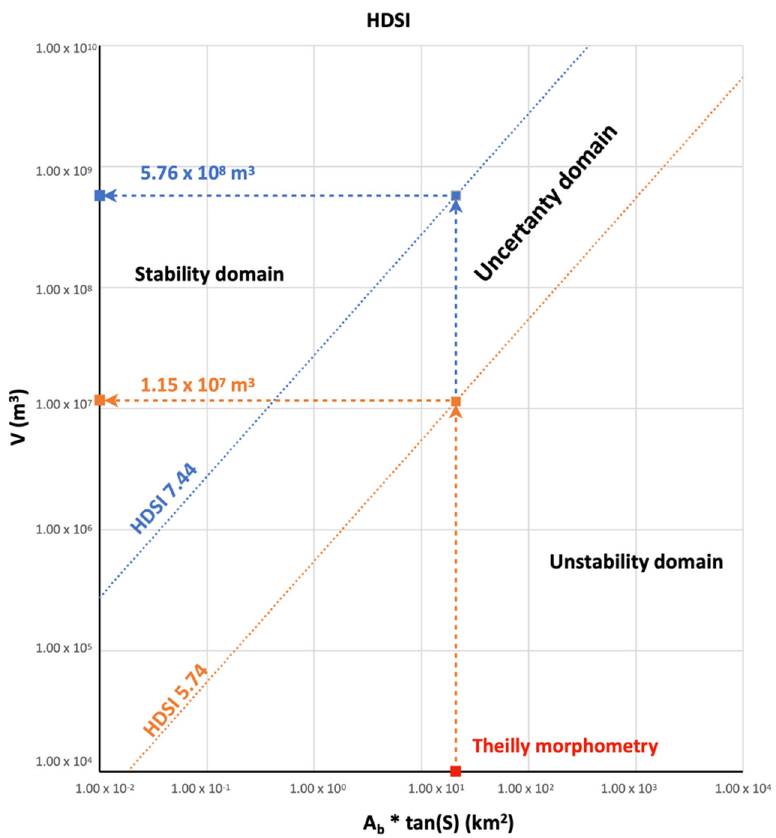
Figure 8. HDSI index graph and identification of the threshold volumes for this case of study.